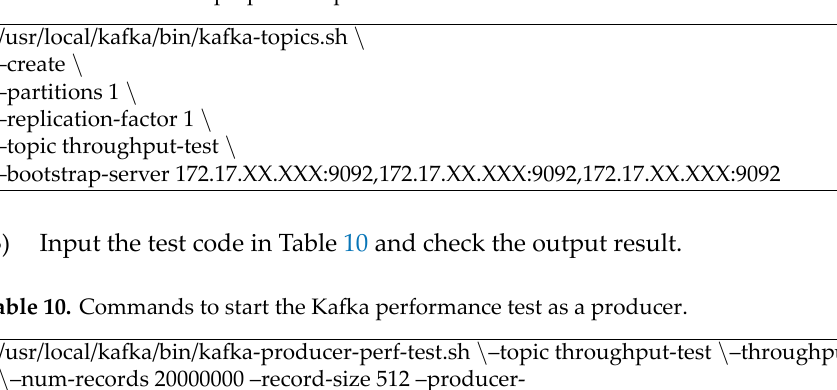
Table 9. Commands to prepare the performance test.